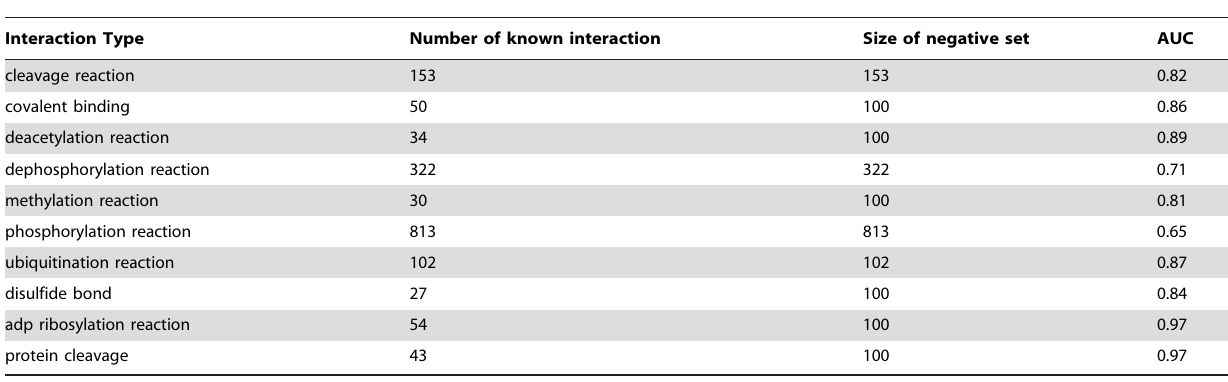
Table 1. Areas under the receiver-operating-characteristic